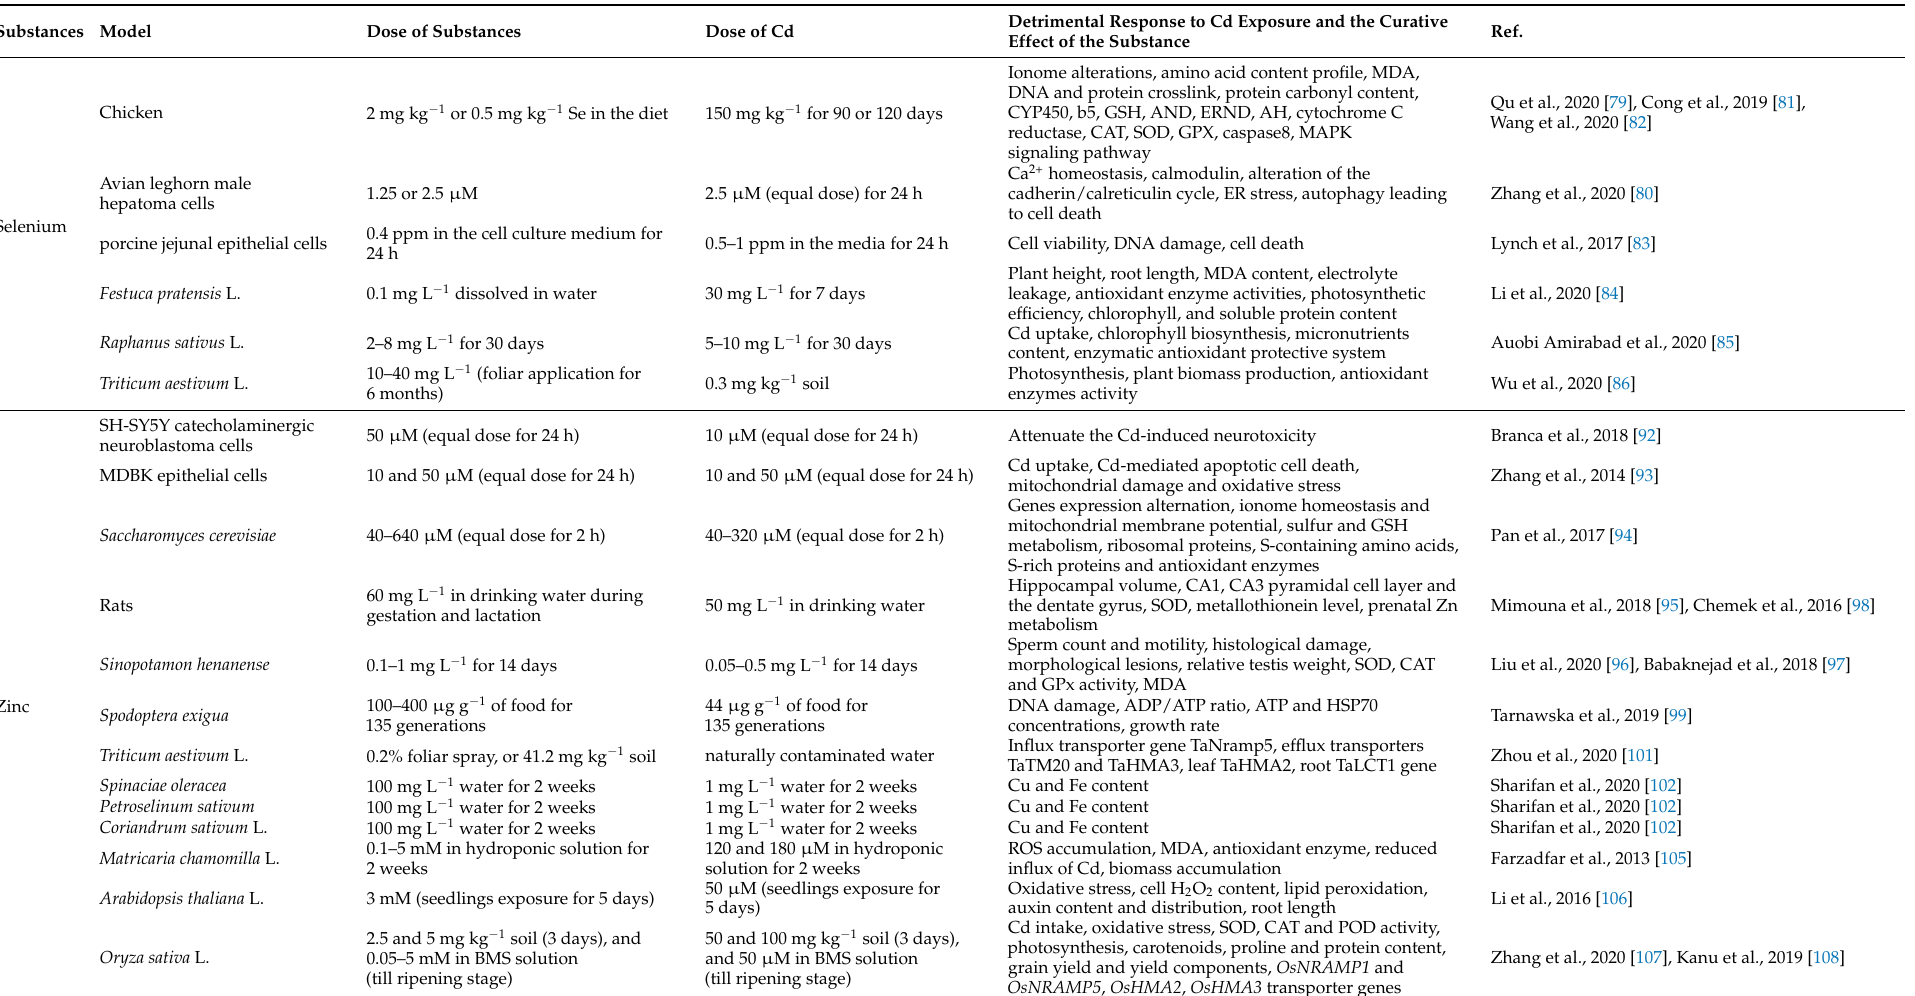
Table 2. Effects of mineral